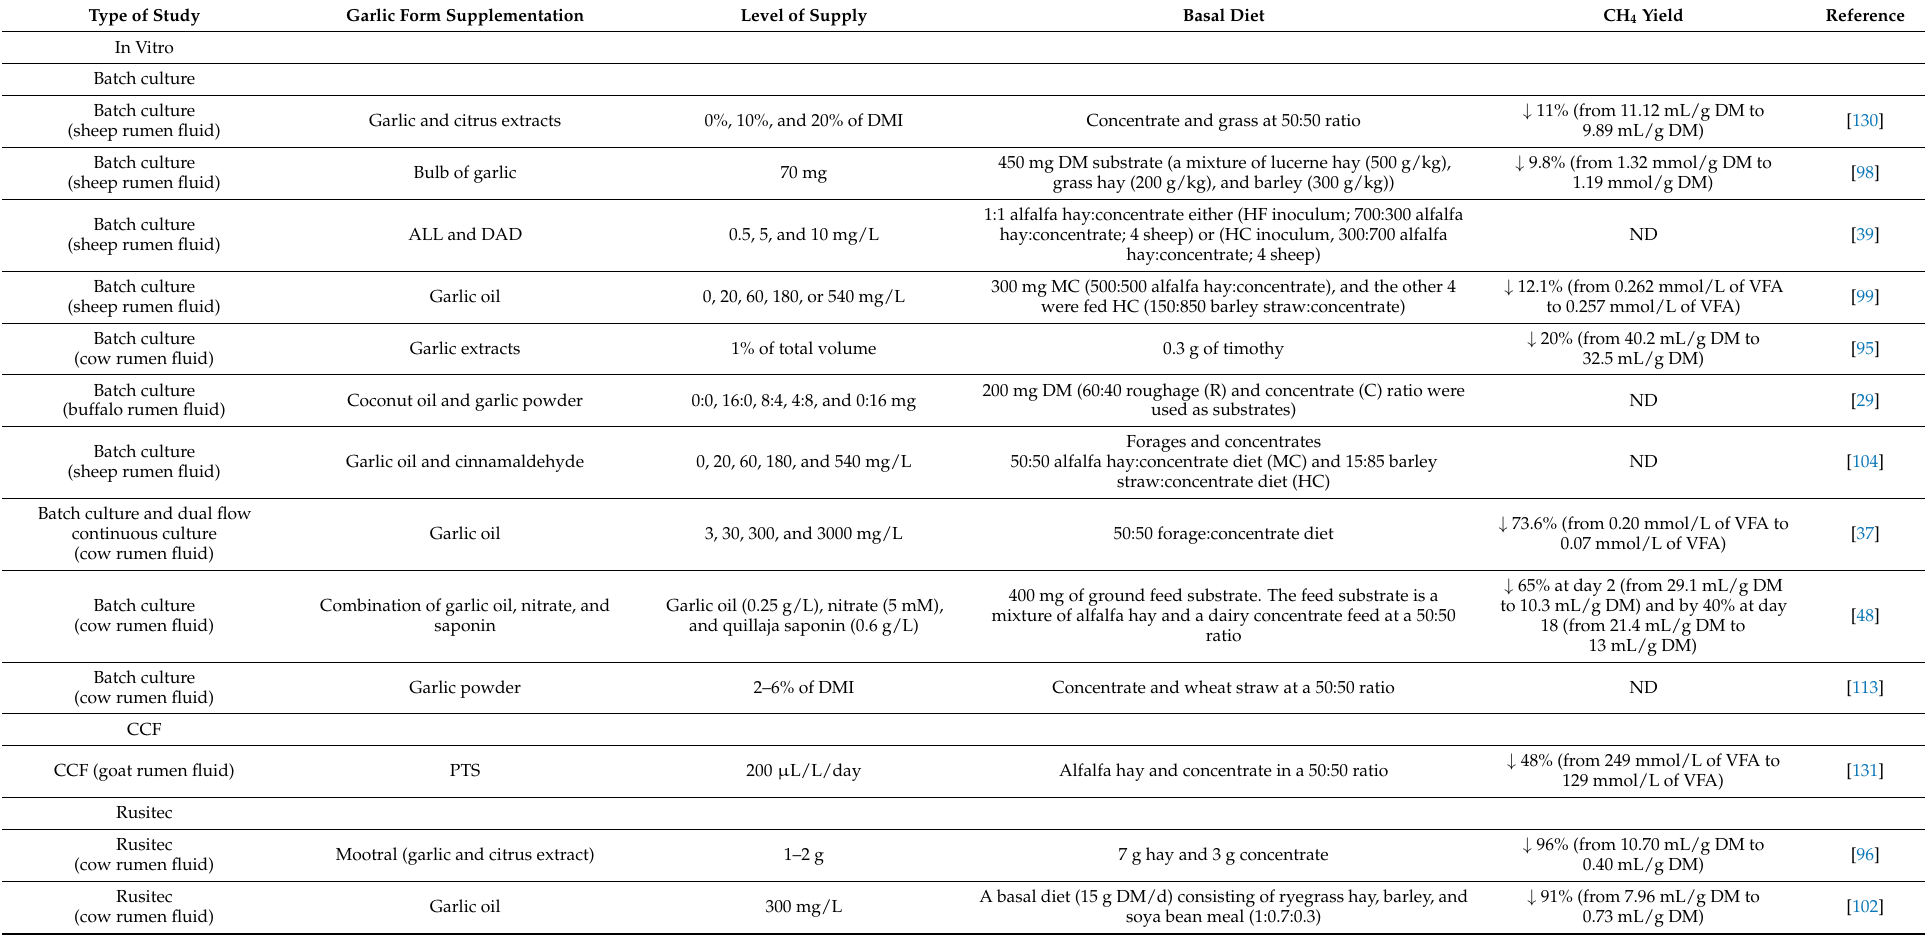
Table 2. Effect of garlic on CH 4 emissions based on in vitro and in